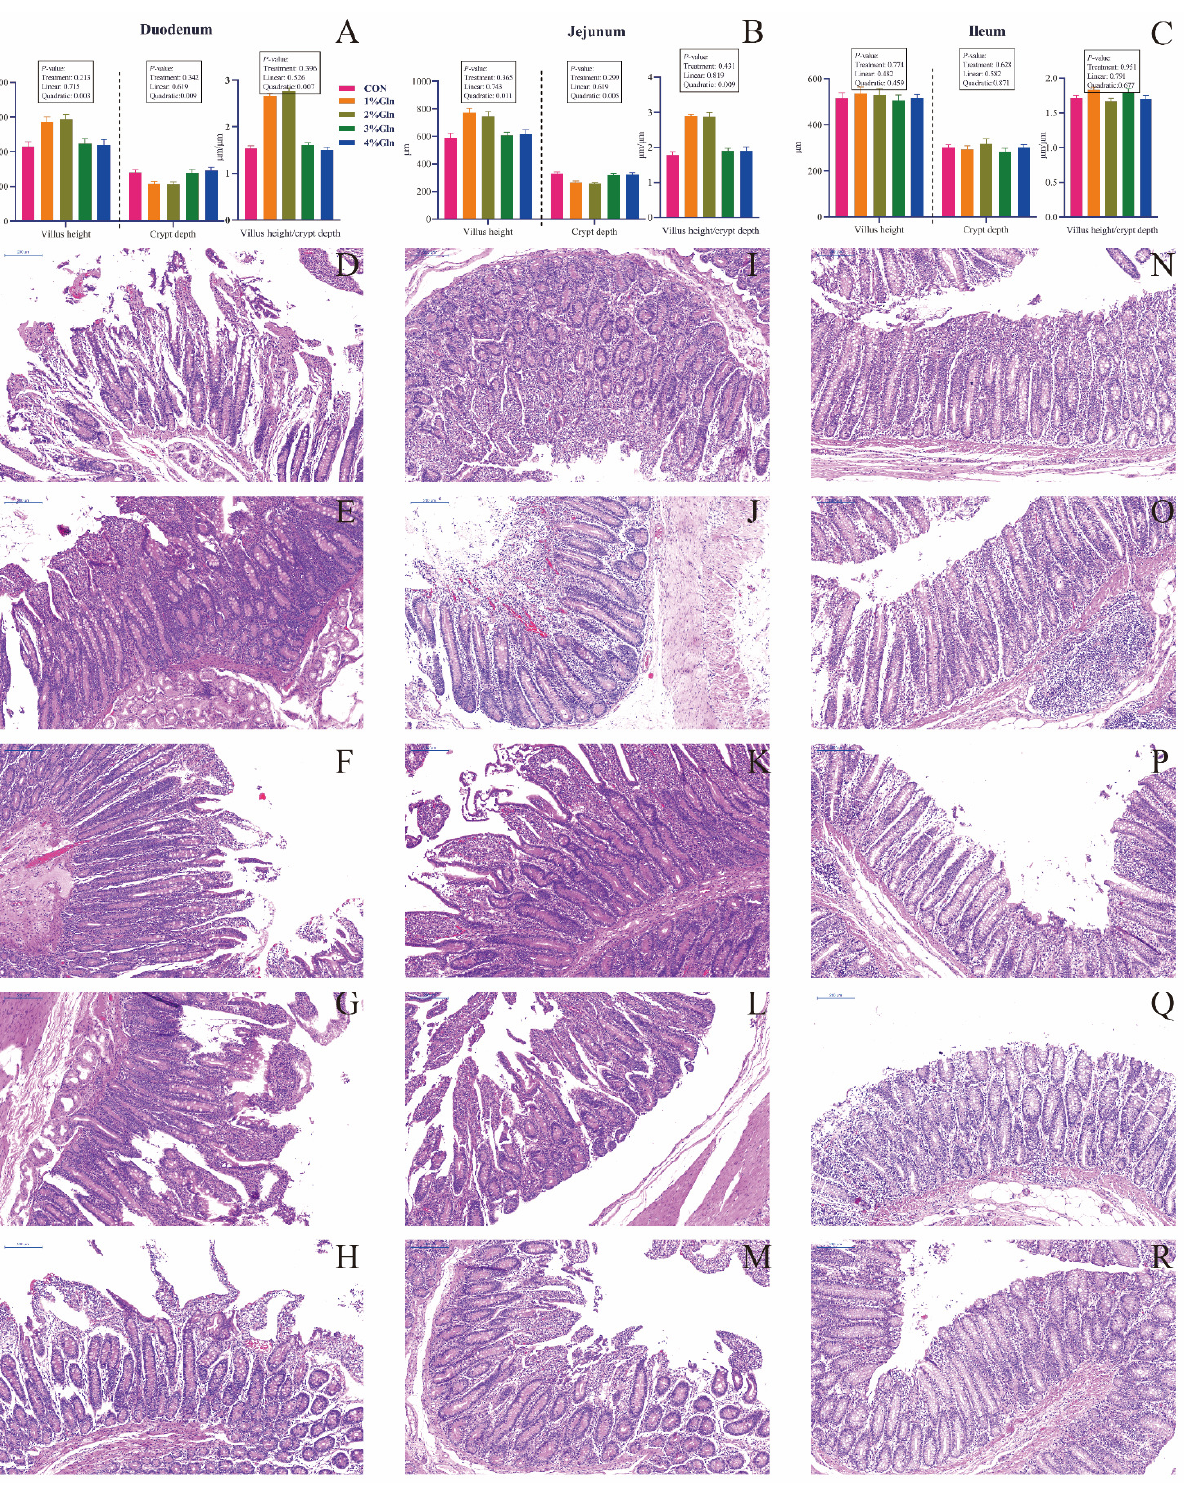
Figure 2. Histomorphology of the small intestine ( A : duodenum, B : jejunum, and C : ileum; mean ± SEM) among different groups (N = 6 per group). Light micrographs (80× magnification, blue bar represents 200 µm) of the duodenum ( D – H ), Jejunum ( I – M ), Ileum ( N – R ) of calves in CON ( D , I , N ) or 1%Gln ( E , J , O ) or 2%Gln ( F , K , P ) or 3%Gln ( G , L , Q ) or 4%Gln ( H , M , R ).